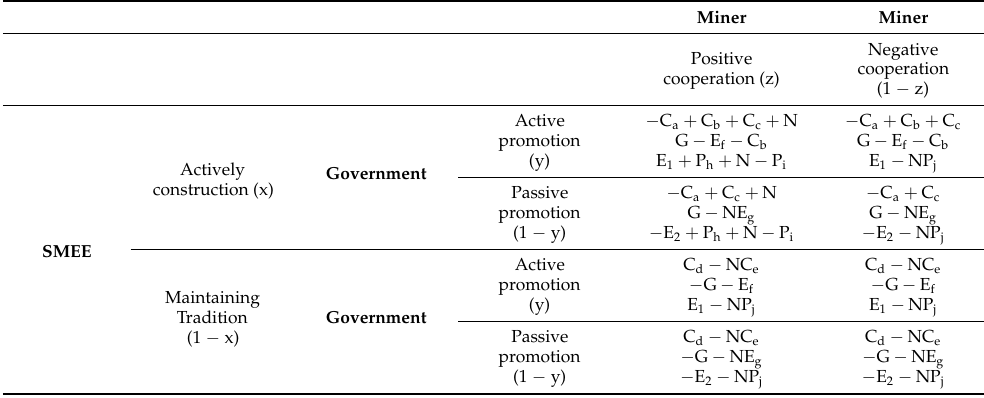
Table 1. Gain perception